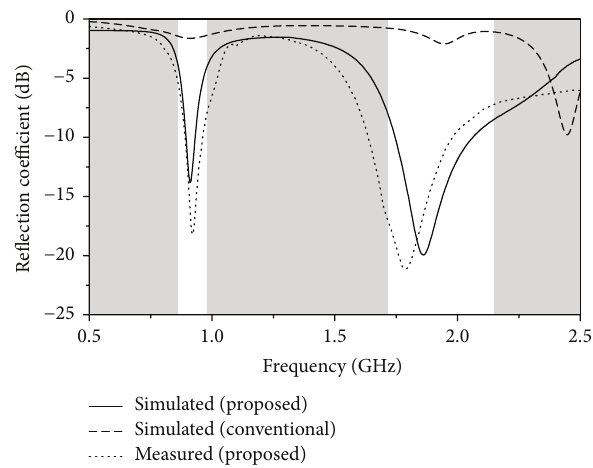
Figure 13: Simulated and measured reflection coefficients of the optimized mobile antenna. The simulated performances for the conventional topology optimization are also provided.